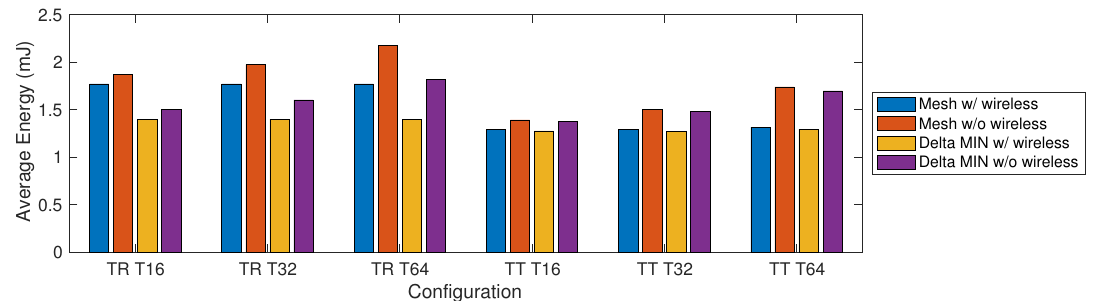
Figure 25. Average energy (mJ) in non-saturated conditions for Delta MIN and mesh topologies of size